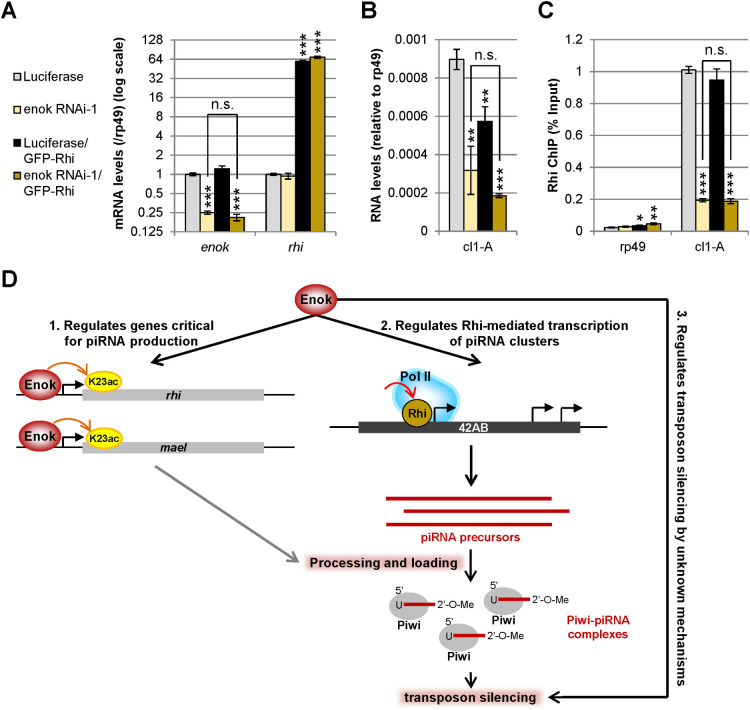
Overexpressing rhi cannot rescue the defective Rhi occupancy at 42AB upon enok knockdown.(A) The efficiency of enok knockdown was similar with or without GFP-rhi overexpression. RT-qPCR analysis of ovaries was used to examine expression levels of the indicated genes. The mRNA levels were normalized to the levels of rp49. (B) Overexpression of GFP-rhi cannot rescue the defective transcription at 42AB upon enok knockdown. The same total RNA samples used in (A) were subjected to strand-specific RT-qPCR analysis for RNAs derived from the dual-strand cluster 42AB. (C) Overexpression of GFP-rhi cannot rescue the defective Rhi recruitment to 42AB upon enok knockdown. The Rhi levels at 42AB in ovaries with or without overexpressed GFP-Rhi were analyzed by ChIP-qPCR. (D) Model of the regulation of piRNA production by Enok in the ovarian germline. Left panel: Enok is localized to and acetylates H3K23ac at genes involved in piRNA biogenesis to promote their expression. Middle panel: Enok facilitates transcription at a subset of piRNA clusters by regulating Rhi recruitment. Right panel: Enok may have other unknown roles in regulating transposon silencing. In (A-C), data represent the mean of three biological replicates +/- SD. The location of amplicons used for 42AB is the same as indicated in Fig 4B. *P < 0.05, **P < 0.01, ***P < 0.001 (Student's t-test). n.s.: not significant. Genotypes of the females are as follows: + / CyO; P{w[+mC] = GAL4::VP16-nos.UTR}CG6325MVD1
/ P{UAS-LUC.VALIUM10}attP2 (Luciferase); + / CyO; P{w[+mC] = GAL4::VP16-nos.UTR}CG6325MVD1/ P{TRiP.HMS02634}attP2 (enok RNAi-1); + / CyO; P{w[+mC] = GAL4::VP16-nos.UTR}CG6325MVD1, UASp-rhi:GFP / P{UAS-LUC.VALIUM10}attP2 (Luciferase/GFP-Rhi); +/CyO; P{w[+mC] = GAL4::VP16-nos.UTR}CG6325MVD1, UASp-rhi:GFP/P{TRiP.HMS02634}attP2 (enok RNAi-1/GFP-Rhi).